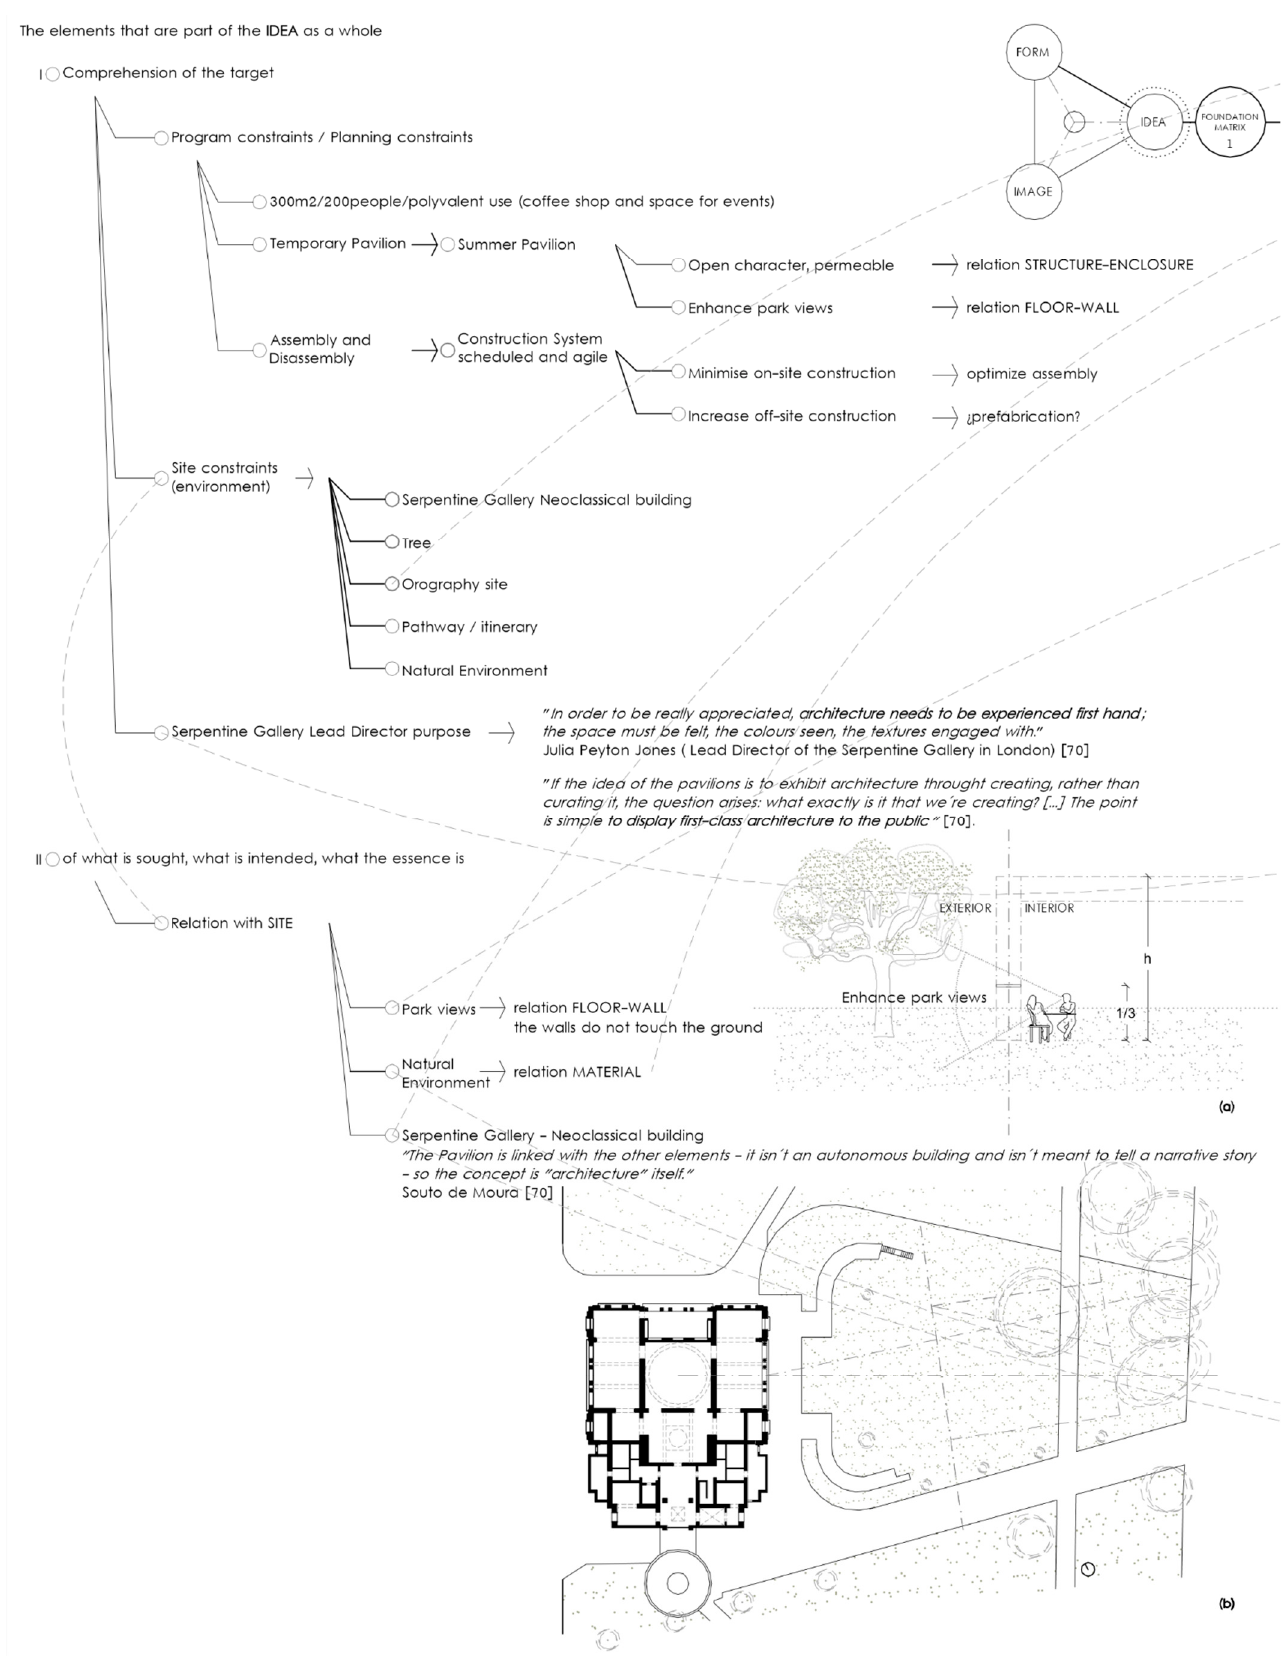
Figure 6. Foundation matrix 1.